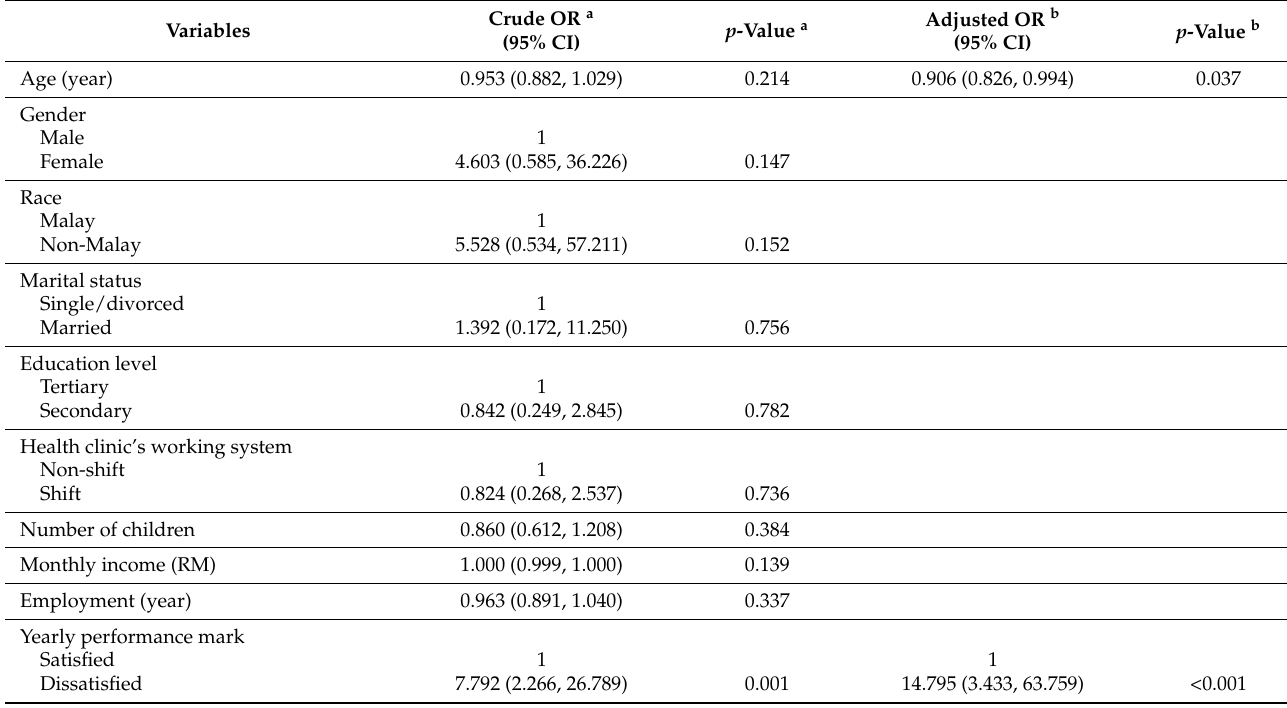
Table 5. Simple and multiple logistic regression analysis for factors associated with job dissatisfaction among healthcare workers working in ‘Type 2 Health Clinics’ in north-eastern Malaysia.